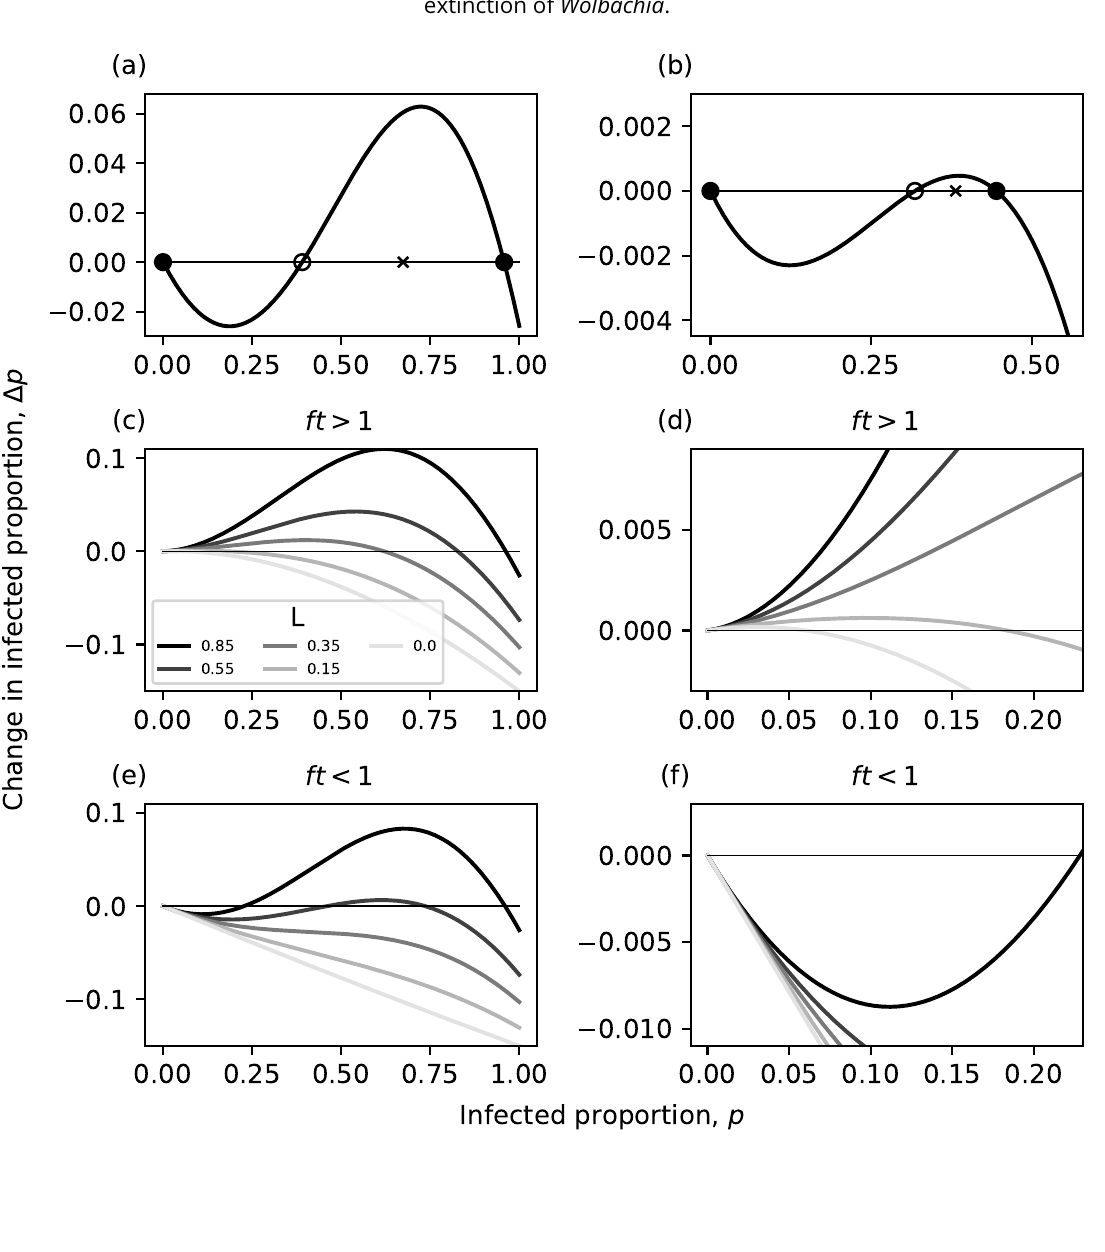
Figure 2. Equilibria of the diplodiploid model (Eq. (1)) shown with plots of ∆ p as a function of p . Dots: stable equilibria, circle: unstable equilibrium, cross: point r . a) Classical example with an invasion threshold and high-frequency stable equilibrium. Parameters f = 0 . 85 , t = 0 . 85 , L = 0 . 85 . b) It is possible to have a low stable frequency ( p < 1 / 2) together with an invasion threshold ( ft = 0 . 9588 < 1 ). ( f = 1 . 128 , t = 0 . 85 , L = 0 . 35 .) Panels c), d) and e), f) contrast the effect of the strength of CI ( L ) on the invasion dynamics when ft > 1 or ft < 1 . In c),d) f = 1 . 19 , t = 0 . 85 , and no invasion threshold exists. Low value of L leads to low stable infection frequency. In e),f) f = 0 . 99 , t = 0 . 85 . High L shows the classic case, while low L predicts extinction of Wolbachia